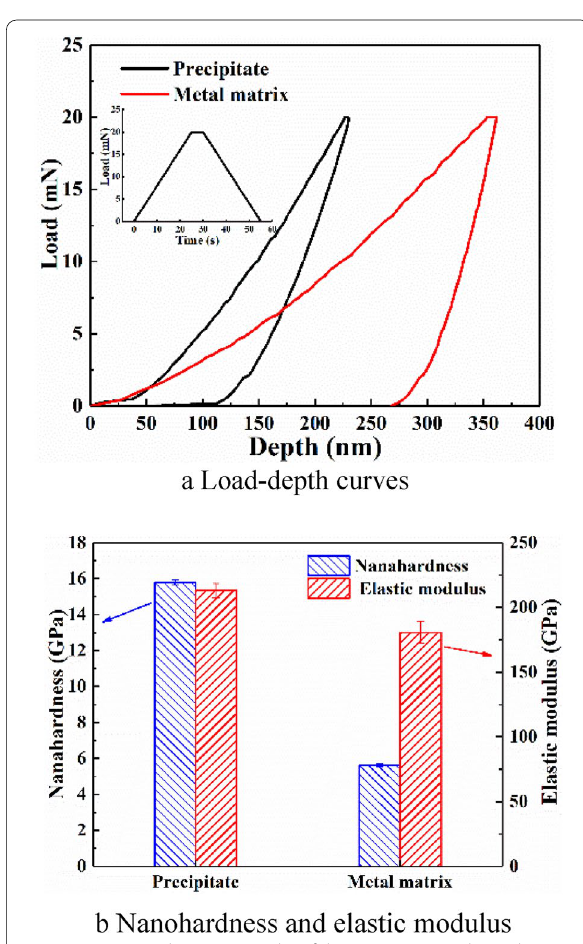
Figure 7 Nanoindentation results of the precipitate and metal matrix